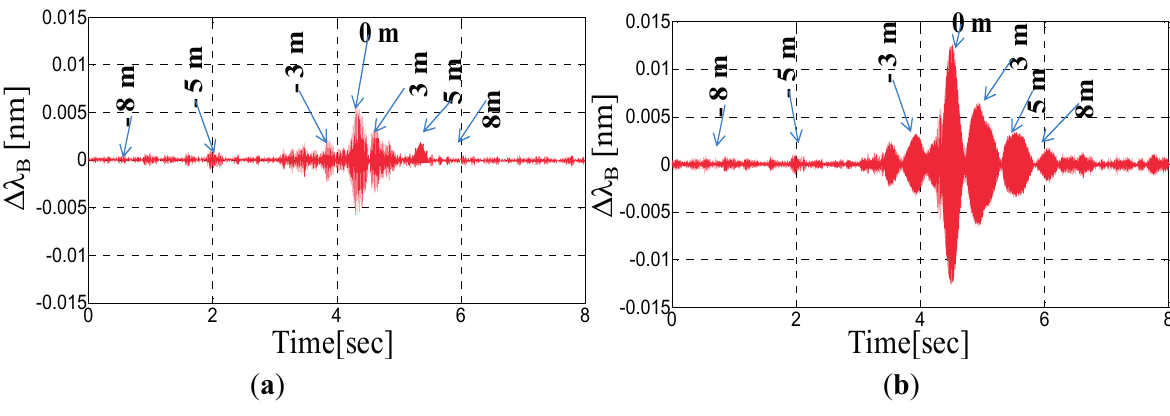
Figure 15. ( a ) Bragg wavelengths of the accelerometers versus time during the intruder’s run between the rail-track for the FBG labeled K1; ( b ) for the FBG labeled